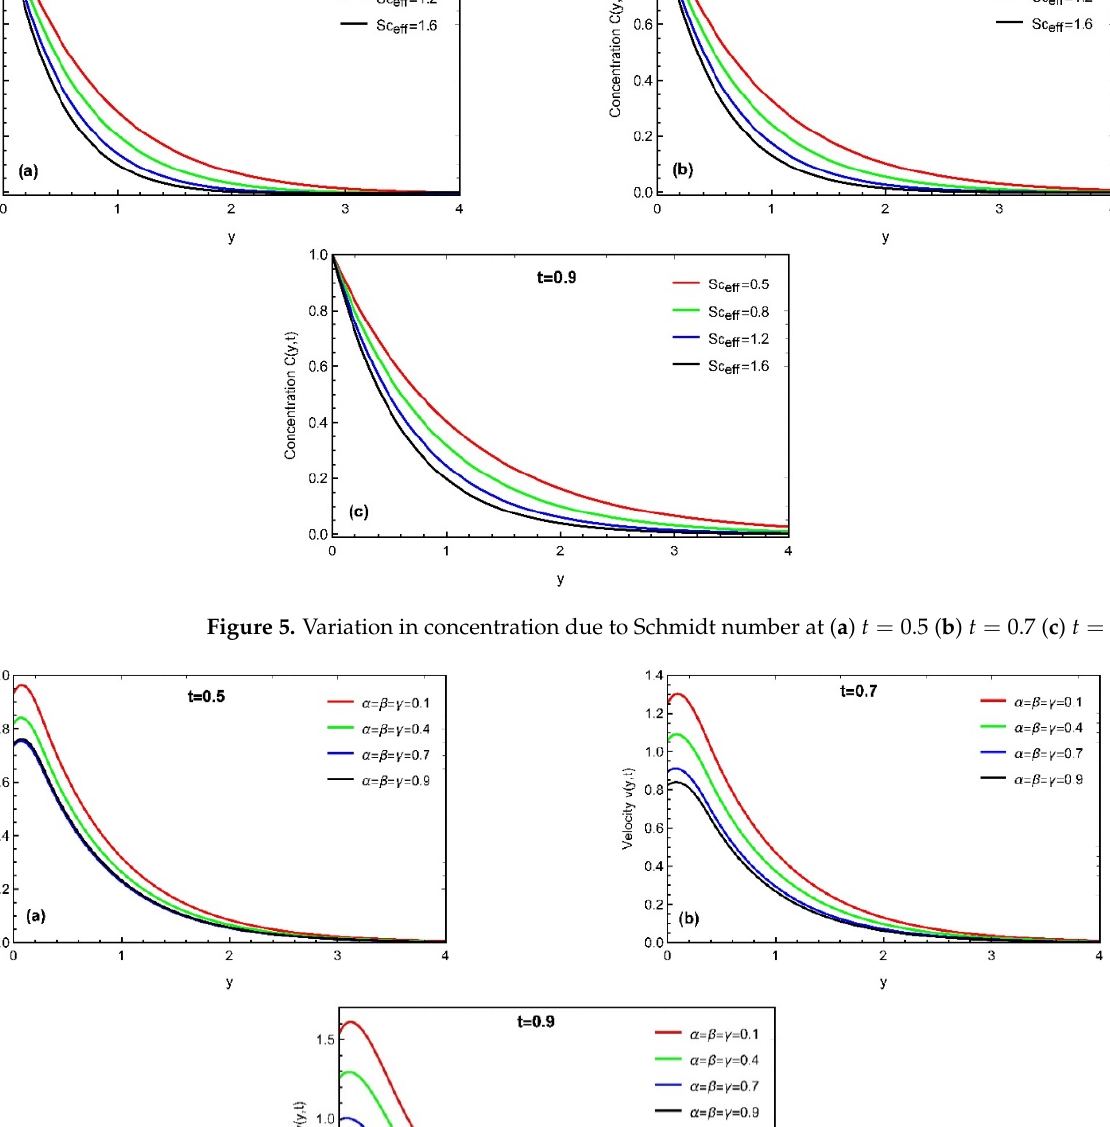
Figure 4. Variation in concentration due to fractional constraints at ( a ) 𝑡 = 0.5 ( b ) 𝑡 = 0.7 ( c ) 𝑡 = 0.9 .